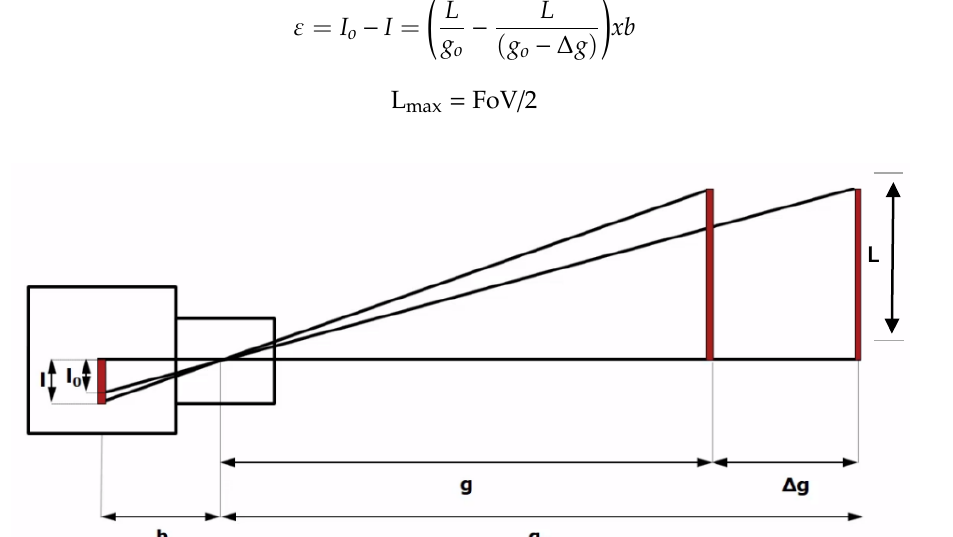
Figure 2. Effect of out of plan movement on monitoring 2D deformations [20]. Figure 2. E ff ect of out of plan movement on monitoring 2D deformations